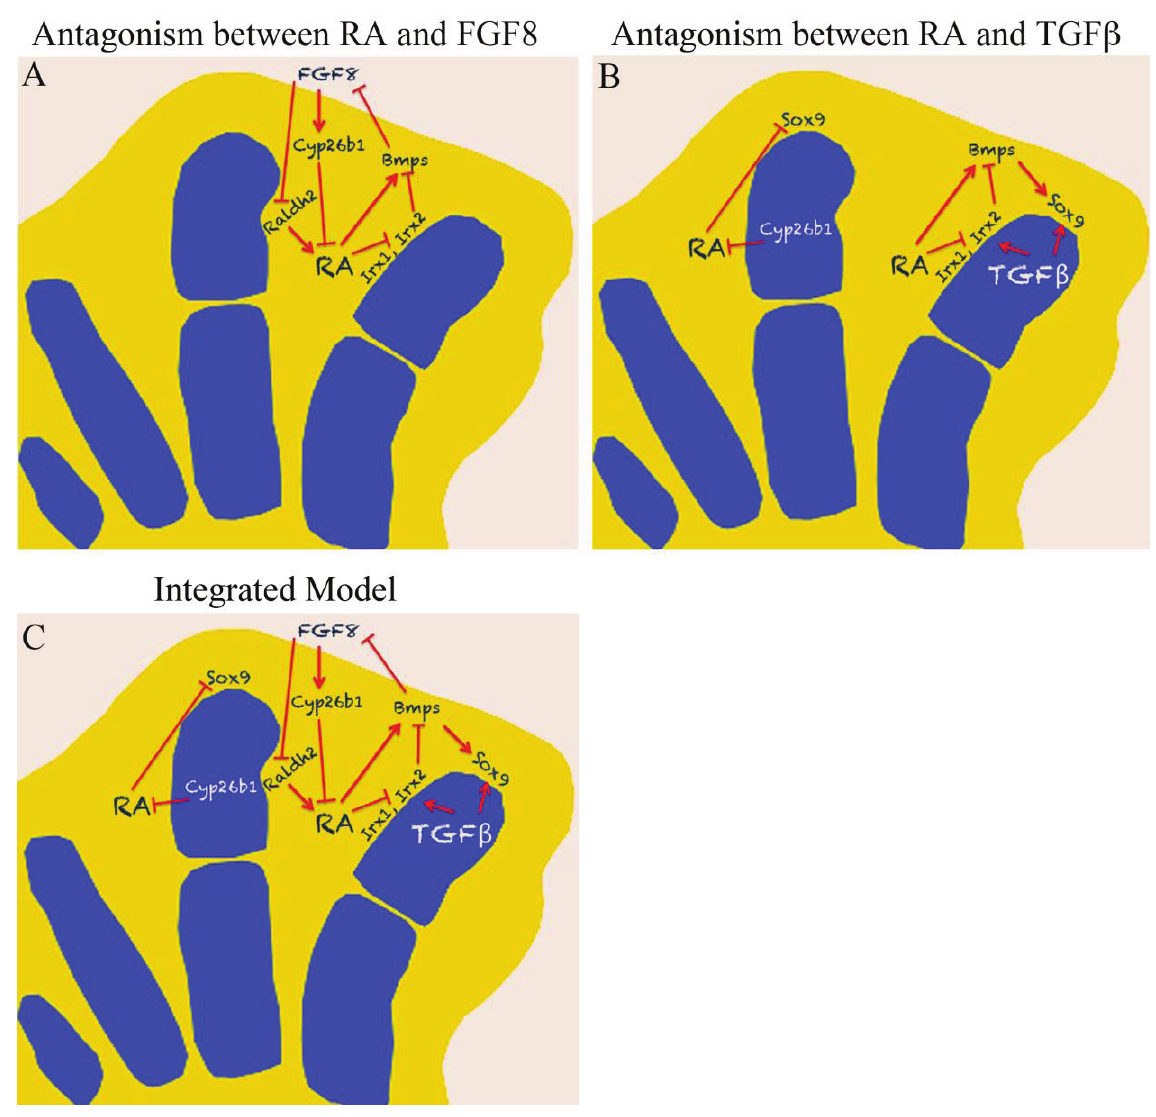
Figure 6. Schematic representation of antagonism between ( A ) RA and FGF8 and antagonism between ( B ) RA and TGFβ. ( C ) Represents the integrated model with both antagonistic interactions (see the text for